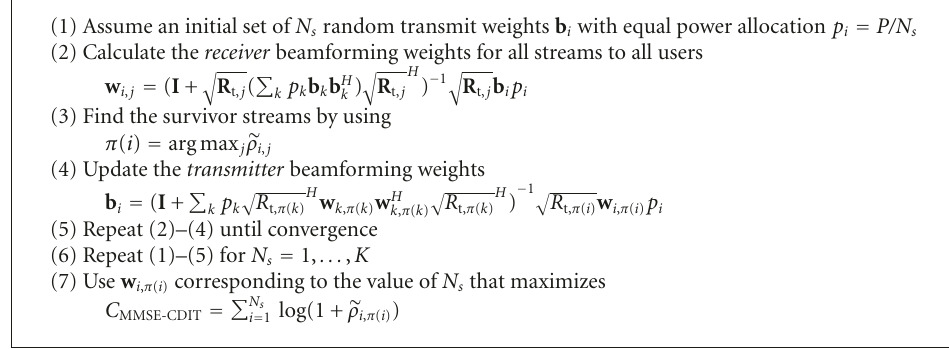
Algorithm 2: Iterative beamforming for maximization of ASET lower